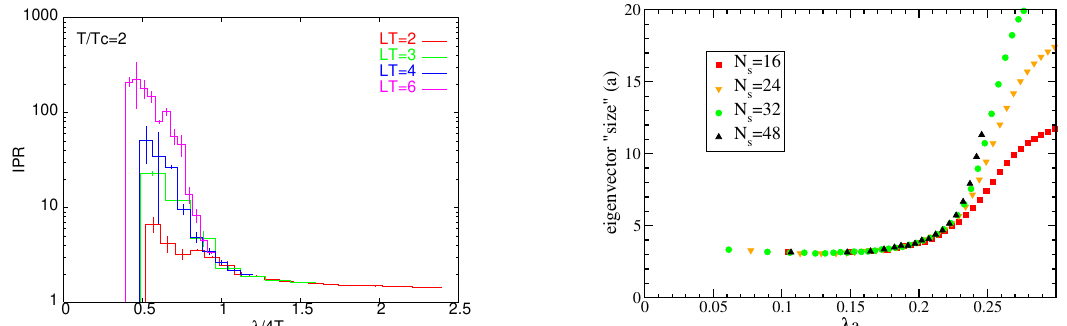
Figure 8. Left : IPR (here times the volume V = L 3 ) of low staggered modes for various volumes at T = 2 T 2 f c in QCD with two flavors of dynamical staggered fermions. From Ref. [29]. (Reprinted figure with permission from R.V. Gavai, S. Gupta, and R. Lacaze, Phys. Rev. D 77, 114506 (2008). Copyright (2008) by the American Physical Society). Right : Mode size for low staggered modes in the background of quenched SU(2) configurations at T = 2.6 T SU ( 2 ) c . From Ref. [32]. (Reprinted figure with permission from T.G. Kovács and F. Pittler, Phys. Rev. Lett. 105, 192001 (2010). Copyright (2010) by the American Physical